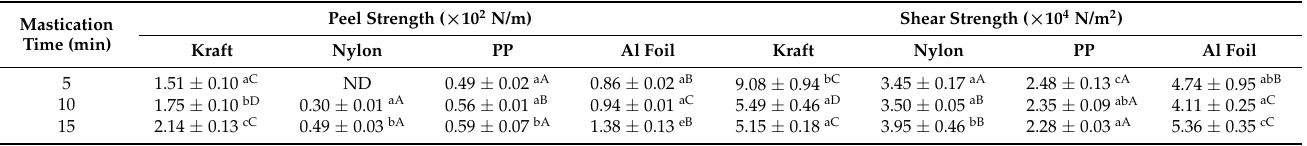
Table 3. Peel and shear strengths of NR-PSA/CO produced with 20 phr of XG + 0.06 phr of CO by using a two-roll mill mixer with a nip gap of 2 mm at various mastication time (5–15 min).